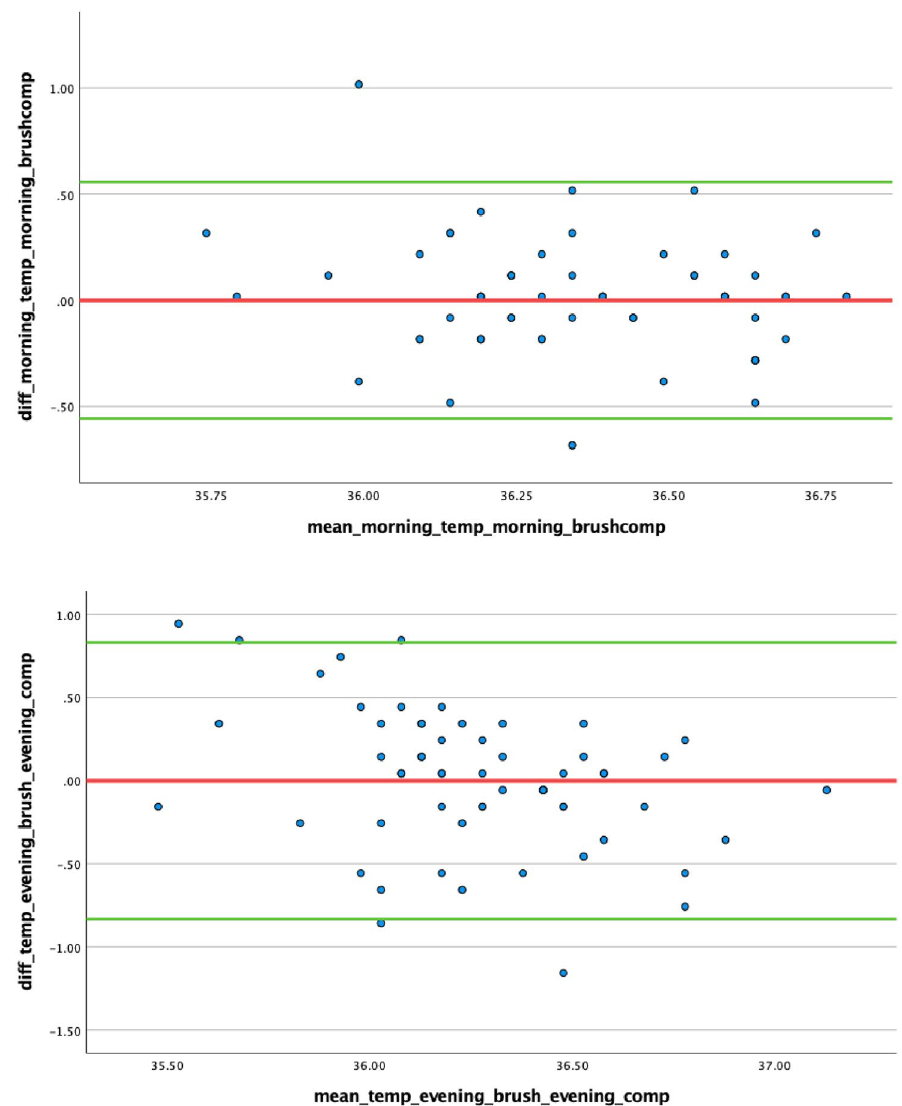
Fig. 3 Bland-Altman plot morning and evening for ID